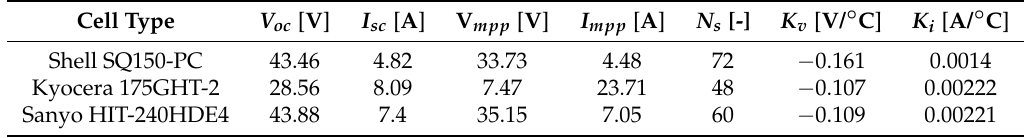
Table 2. Data for evaluating the model parameters of Shell SQ150-PC, Kyocera 175GHT-2, and Sanyo HIT 240HDE4 at the standard test condition